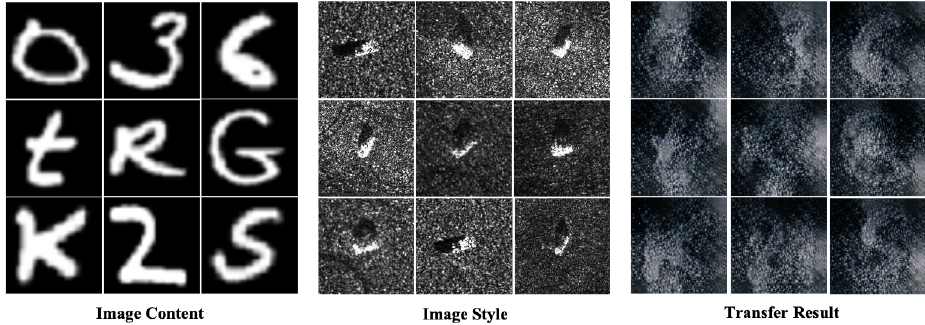
Figure 3. A partial display of the results of the style transfer from the MSTAR dataset to the EMINIST dataset.